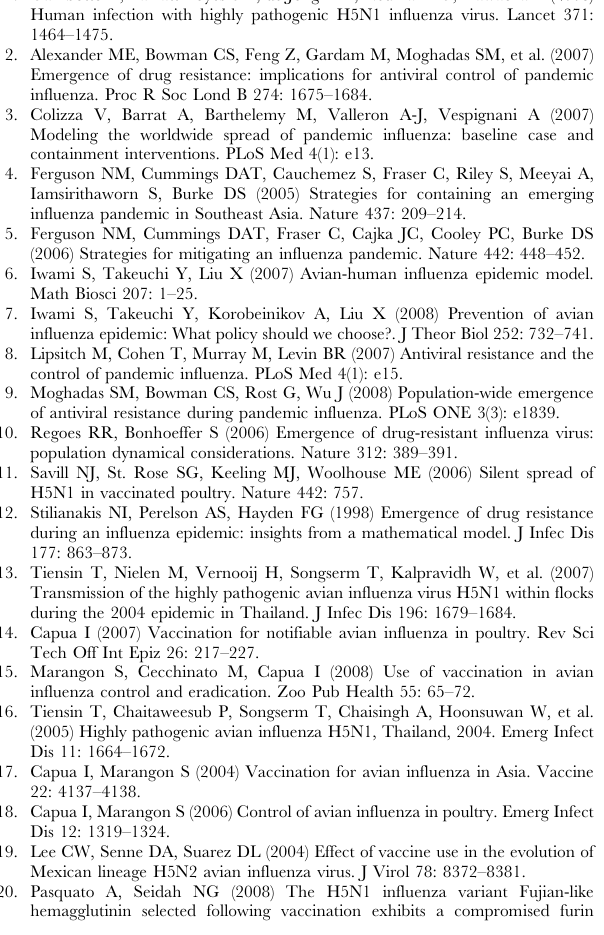
Figure S9 Found at: doi:10.1371/journal.pone.0004915.s009 (1.72 MB EPS) Figure S10 Found at: doi:10.1371/journal.pone.0004915.s010 (0.96 MB EPS) Figure S11 Found at: doi:10.1371/journal.pone.0004915.s011 (1.35 MB EPS) Text S1 Found at: doi:10.1371/journal.pone.0004915.s012 (0.09 MB PDF) Author